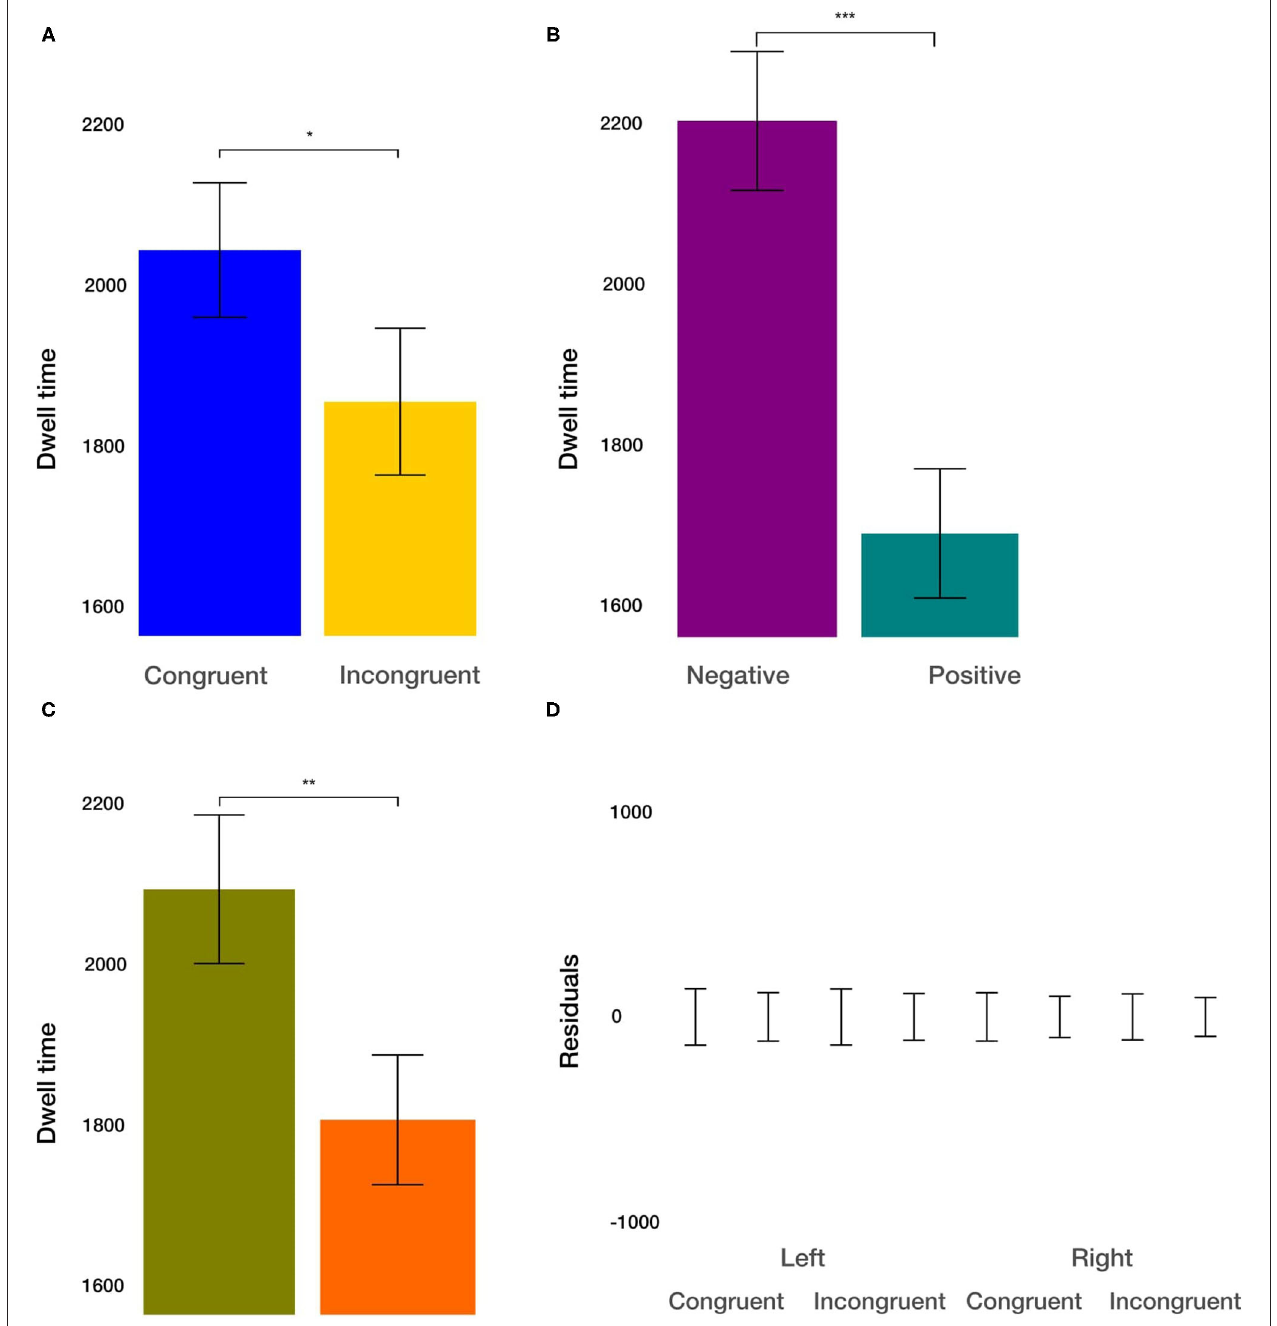
FIGURE 6 | Dwell time results. (A) The main effect of the congruency of the priming. (B) The main effect of image valence (negative vs. positive). (C) The main effect of the side (left vs. right). (D) Averaged residuals of all condition combinations from the dwell time linear mixed model. In all plots, bars represent mean values and whiskers standard error of the mean. Stars represent significance levels: * p < 0.05, ** p < 0.01, and *** p < 0.001.